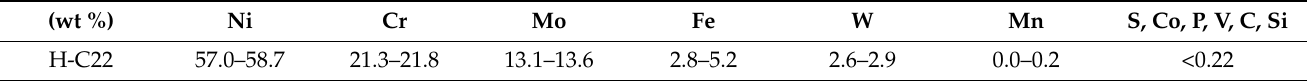
Table 2. Chemical composition (wt %) of the active brazing alloy